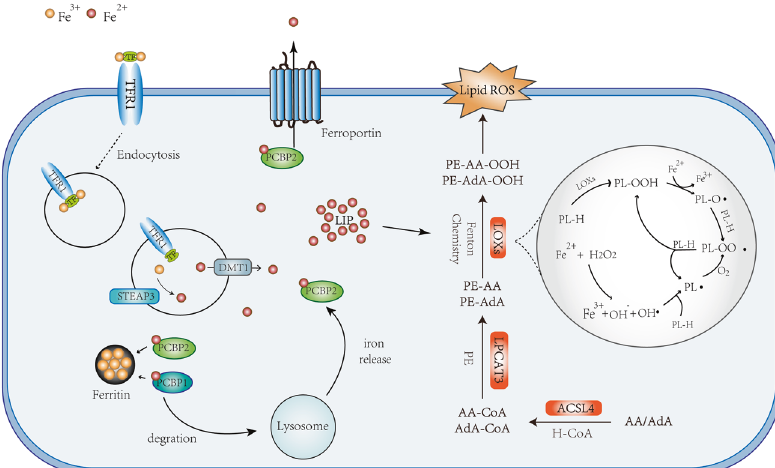
Fig. 2 Schematic description of the signaling pathway of ferroptosis. The indicated pathways control ferroptosis sensitivity via lipid ROS generation. Phosphatidylethanolamines (PE); phospholipid (PL-H); phospholipid alkoxyl radical (PL-O·); phospholipid peroxyl radical (PL-OO·); phospholipid hydroperoxide (PL-OOH); transferrin (TF). The symbols used in the fi gure have been marked with names of the